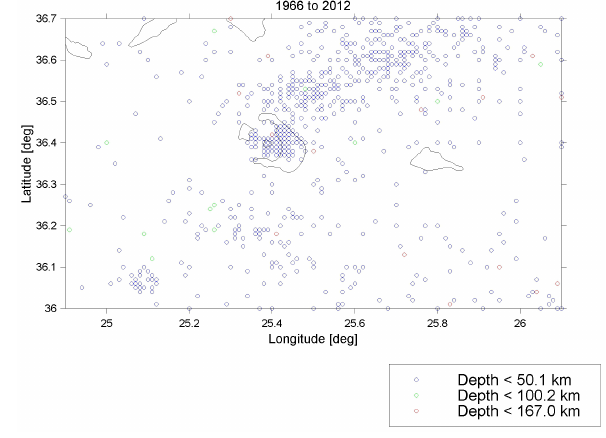
Fig. 2. Seismicity recorded in the Santorini region from 1966 to the end of 2011 (14 December), from the earthquake catalog of the National Observatory of